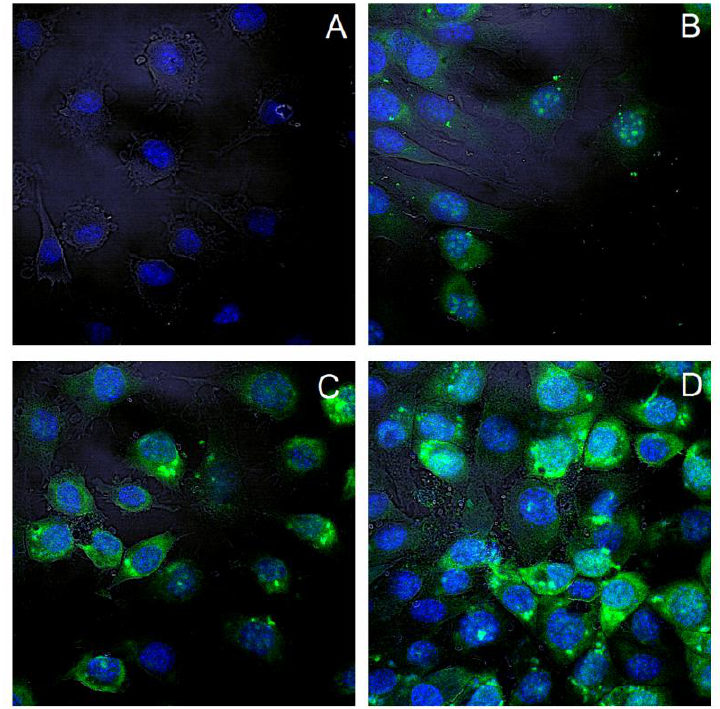
Figure 13. Confocal pictures of blank cells ( A ), PEI 25k ( B ), pDMAEMA pHEMA ( C ), pDMAEMA -block- pHEMA ( D ) transfected cells. Green: YoYo-1 57 151 91 labeled pDNA, blue—DAPI stained